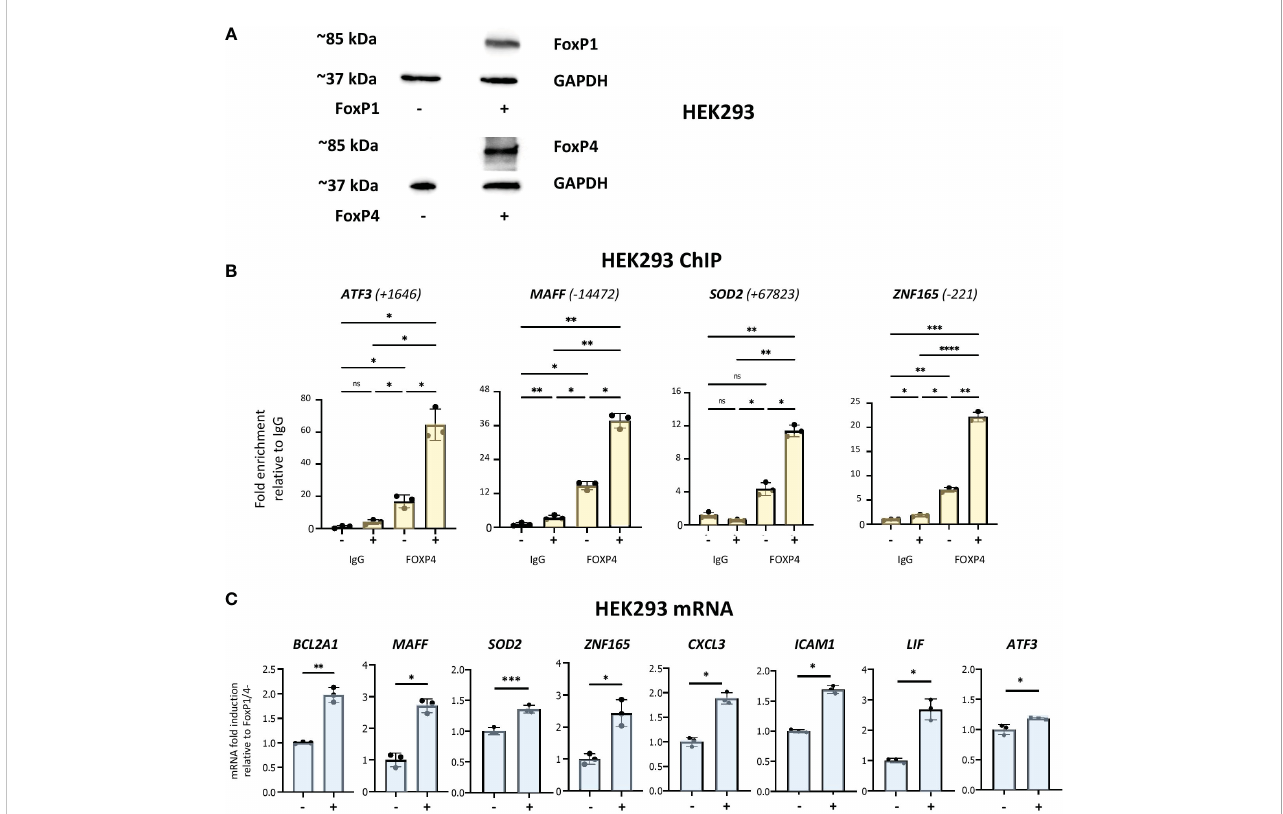
FIGURE 7 Analysis of forkhead box protein DNA-binding and gene regulation in HEK293 cells. (A) Western analysis of FOXP1 and FOXP4 protein expression in HEK293 cells transfected with or without FOXP1 and FOXP4 expression vectors, as indicated. (B) Analysis of the association of FOXP4 with up- and downstream regulatory regions of ATF3, MAFF, SOD2 and ZNF165 by ChIP assay in HEK293 cells transfected with and without FOXP1 and FOXP4 expression vectors. Data representative of 2 or 3 biological replicates. Graphics are mean ± SD from 3 technical replicates from a representative sample and paired one-way ANOVAs followed by Tukey ’ s post hoc test for multiple comparisons were used (*P ≤ 0.05, **P ≤ 0.01, ***P ≤ 0.001, ****P ≤ 0.0001 and ns ≥ 0.05). ChIP values are normalized to input for each condition and expressed as a fold relative to non-speci fi c IgG control. (C) RT/qPCR analysis of FOXP1/4 network genes in HEK293 transfected with and without FOXP1 and FOXP4 expression vectors. Data representative of 2 or 3 biological replicates. Graphics are mean ± SD from 3 technical replicates from a representative sample and paired, two-tailed t-test (Student ’ s t-test) was used (*P